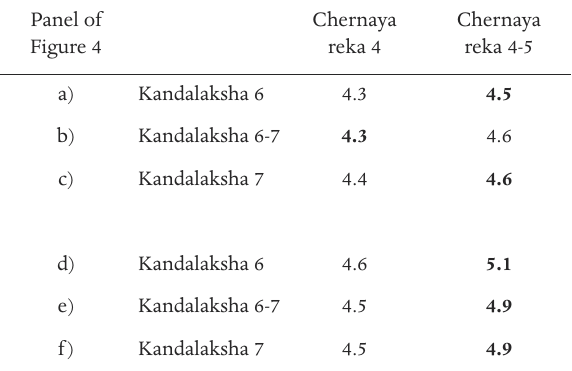
Table 3. Earthquake of December 17, 1758: magnitudes corre- sponding to different combinations of intensities in Kandalaksha and Chernaya reka are shown. The best-fitting values are given in a bold font. They correspond to the epicenter solutions having the smallest intersection of circles illustrated in Figure 4. The corre- would be 6-7, 7, or 7-8 in cases a, b sponding epicentral intensity I 0 and c, and I would be 7-8 or 8 in cases d, e and f. 0